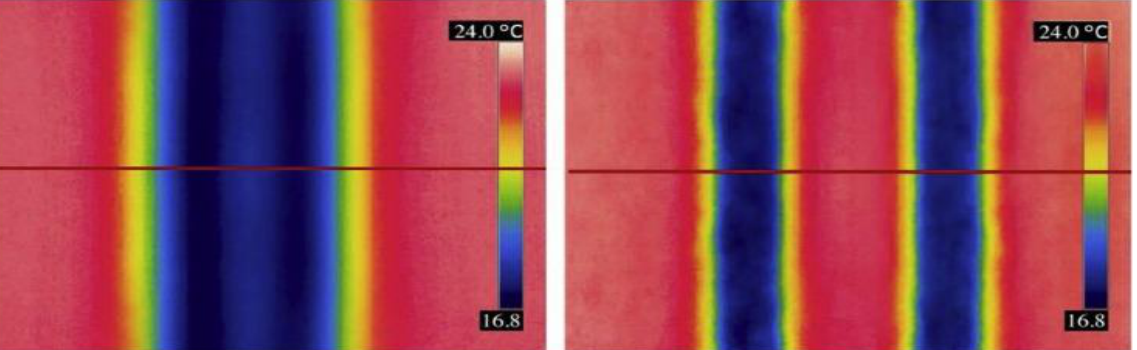
Figure 12. Sample IR images for specimens with parallel thermal bridges created by square hollow steel (SHS); two parallel thermal bridges positioned at a distance apart smaller than the specimen thickness ( left ), and two parallel thermal bridges positioned at a distance apart greater than the specimen thickness ( right ). Reproduced from O’Grady et al. [90].